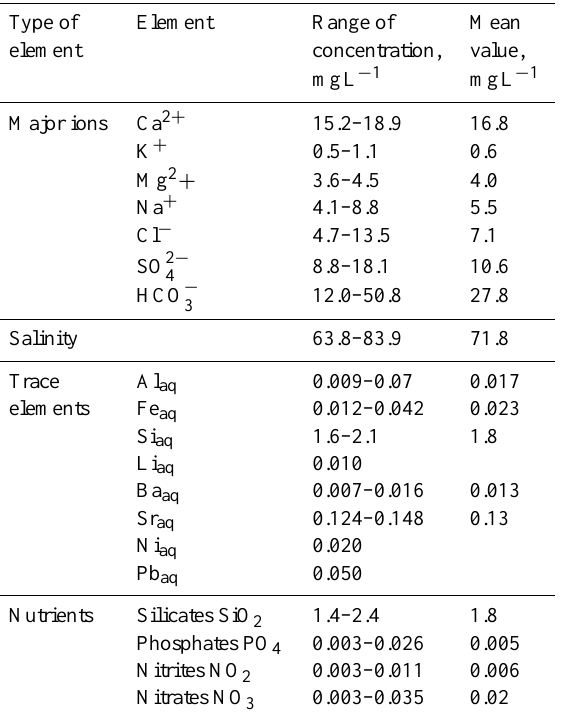
Table 3. The range of dissolved element content concentrations of main ions and trace elements in water of Lena River delta large branches from the summer period (July–August), 2010 to